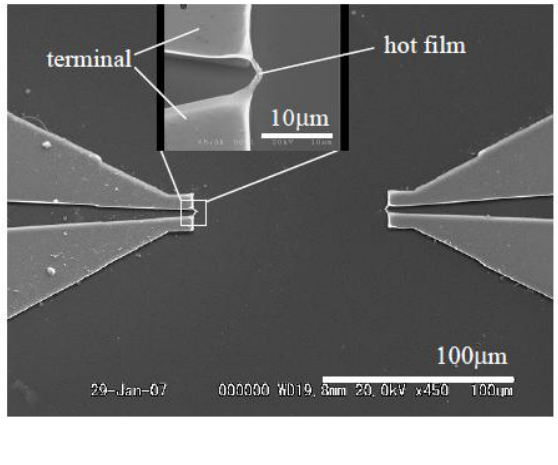
Figure 4. Micromachined Pt resistor used for thermoresistive flow sensing